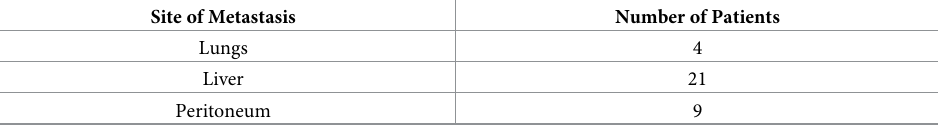
Table 1. Site of metastasis.